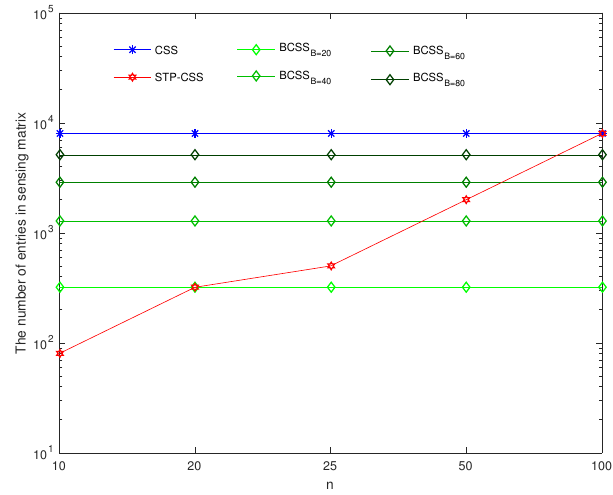
Figure 12. The comparison of storage performance in CSS, BCSS, and PTP-CSS. The blue, green, and red lines represent CSS, BCSS, and PTP-CSS, respectively. In the BCSS, the sizes of each block B are set to 20, 40, 60, and